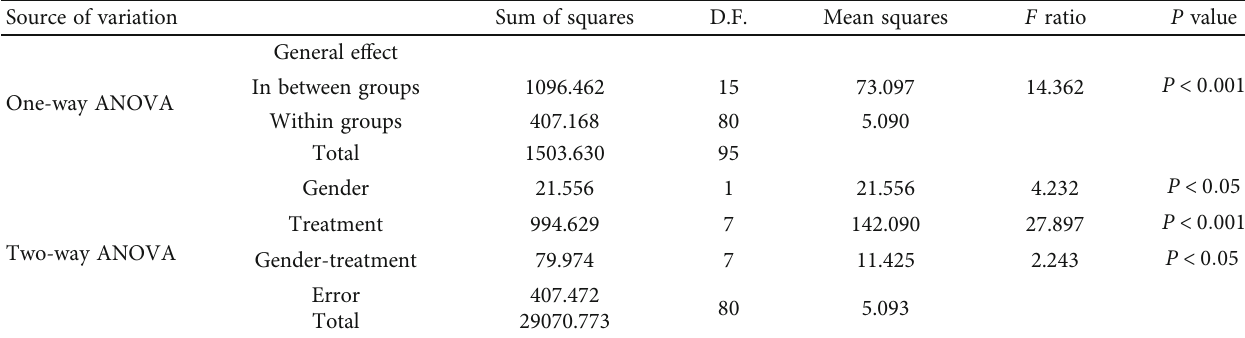
Table 10: One-way and two-way analysis to test the e ff ect of gender, treatment, and their interactions on GPx activity in rats. Source of variation Sum of squares